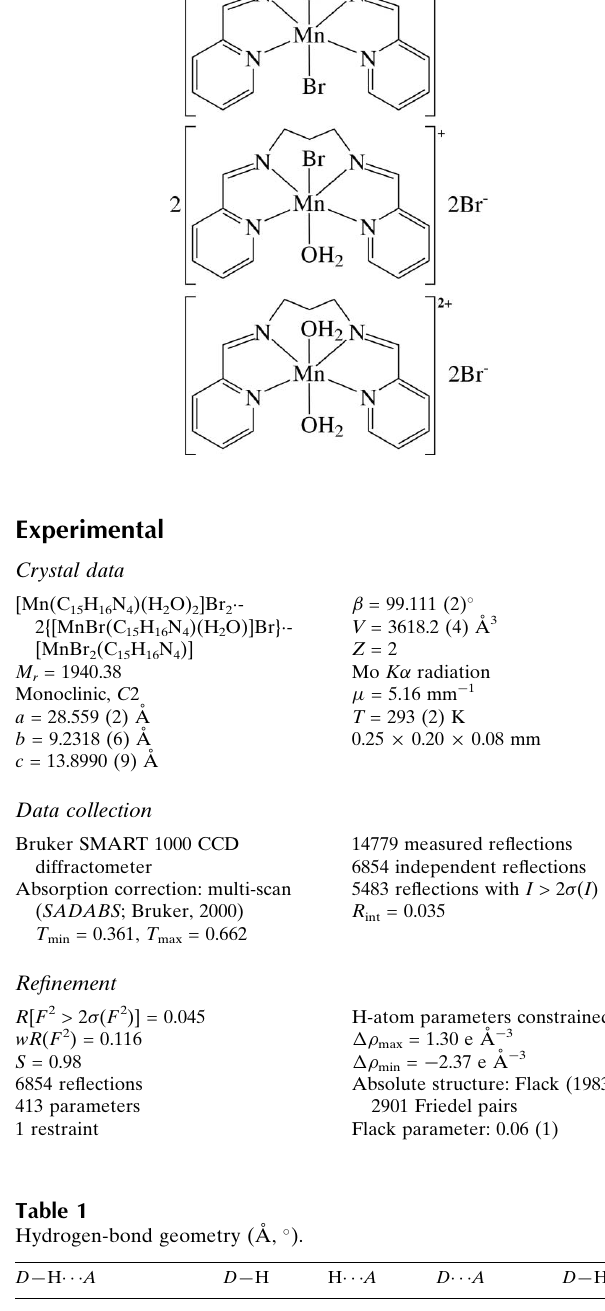
bonding. There are intermolecular (cid:2) – (cid:2) interactions between adjacent pyridine rings, with centroid–centroid distances of 3.822 and 3.833 A˚ , and a C—H (cid:1) (cid:1) (cid:1) O interaction is also present.